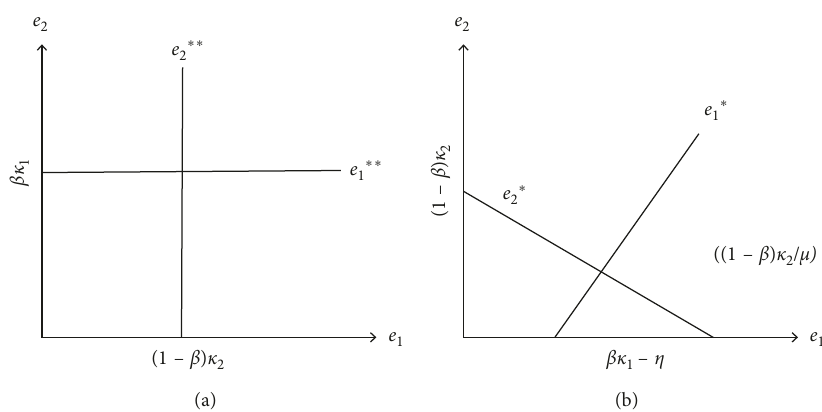
Figure 1: The effort levels of the owner and contractor under different